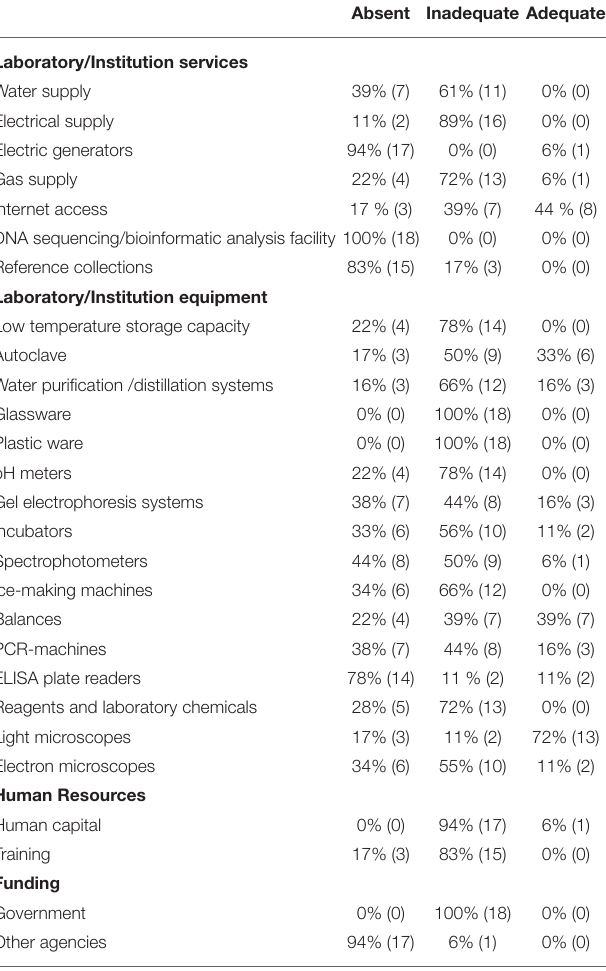
TABLE 2 | Percentage of plant diagnostic laboratories using diagnostic methods, TABLE 1 | Survey respondents’ rating of the exploratory phytosanitary capacity determined by the diagnostician evaluation. Absent Inadequate Adequate